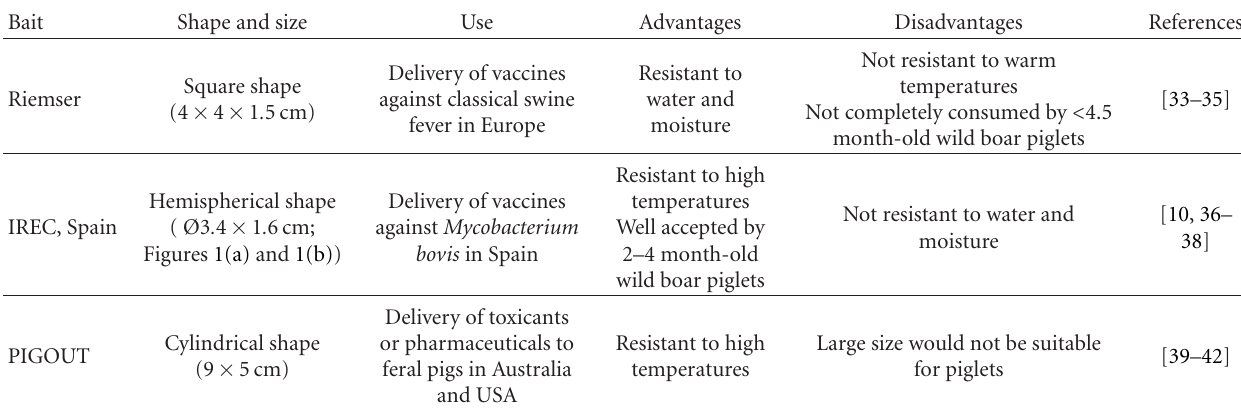
Table 1: Characteristics of commercial, registered, or patented baits designed for the delivery of vaccines or pharmaceuticals to wild boar and feral pigs. Disadvantages include particularly their suitability for vaccine delivery to